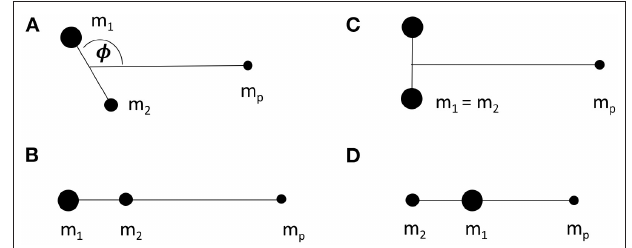
FIGURE 1 | A schematic representation of possible binary star - planet geometries representing irradiation minima: (A–C) and maxima (D) for various mass ratios of the binary star ( m 2 / m 1 ). A standard mass-luminosity relation for main sequence stars is assumed. The more massive star is m 1 , the less massive star is m 2 , and the planet is represented by m p